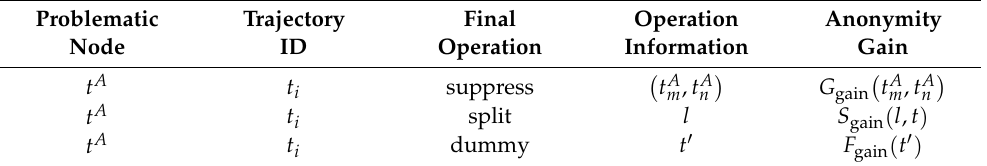
Table 3. Array of PreGain .